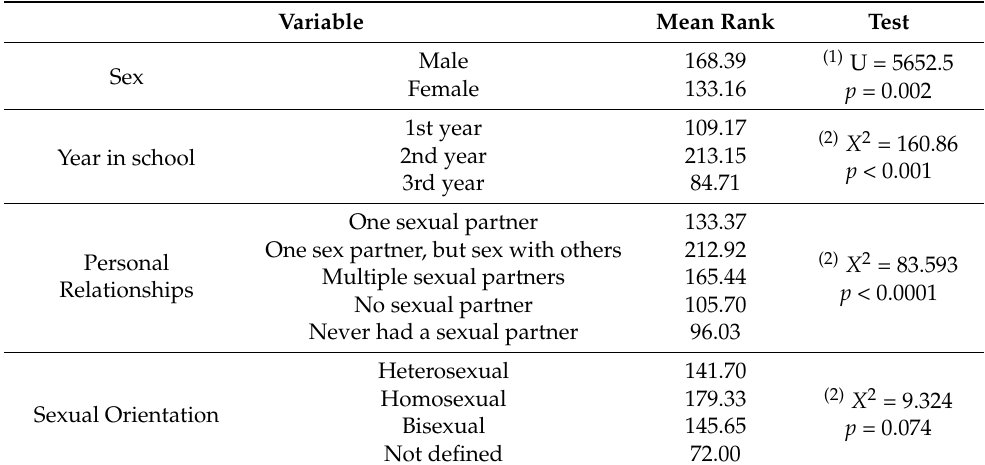
Table 3. Differences between Variables In Relation To Total SABS